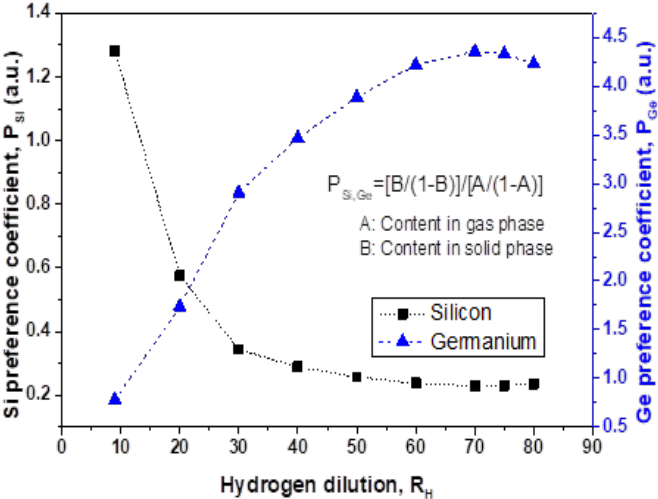
Figure 5. Coefficients of preferential incorporation of Si and Ge atoms, P Si and P Ge , as a function of hydrogen dilution.